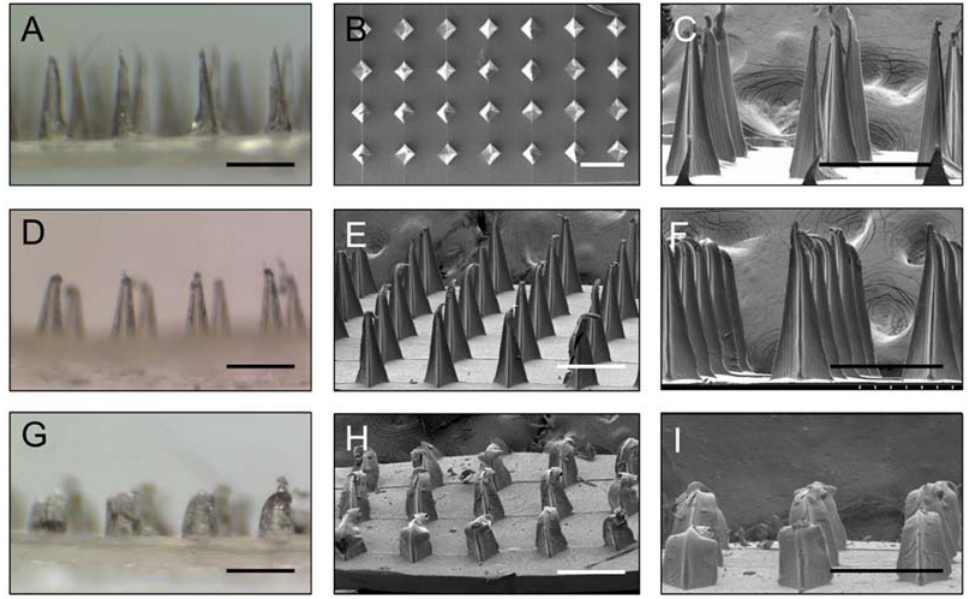
Figure 2. ( A ) Stereomicroscopy images and ( B , C ) scanning electron microscopy images of gelatin/CMC MNs before insertion. ( D – F ) The MNs 10 min after insertion. ( G – I ) The MNs 30 min after insertion. Scale bar = 500 μ m.